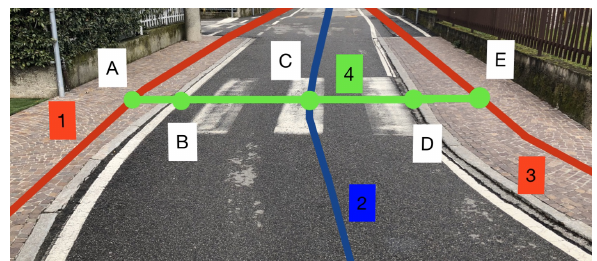
Figure 2. Simple schema of the mapping of crossings. In the white boxes the letters of the nodes, in the red/blue boxes the numbers of the